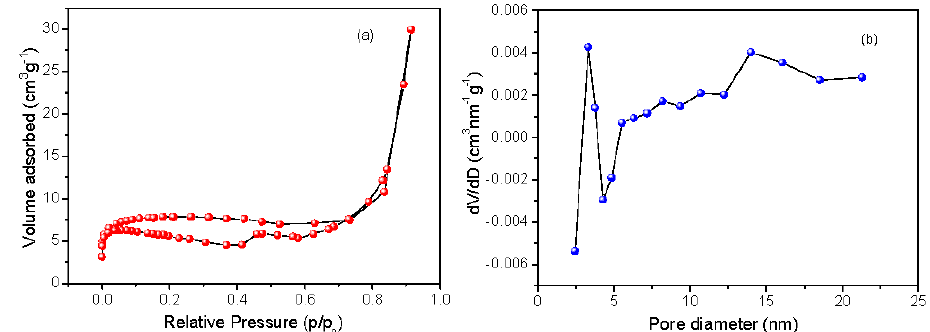
Figure 10. ( a ) N 2 adsorption–desorption isotherms and ( b ) pore size distribution of ZnO-CeO 2